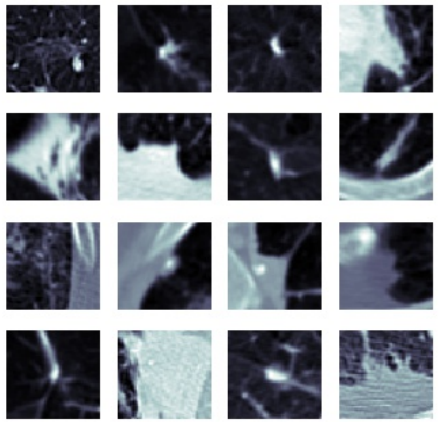
Figure 32. SFMPF model based on LOG image—missed non-nodules (FP).